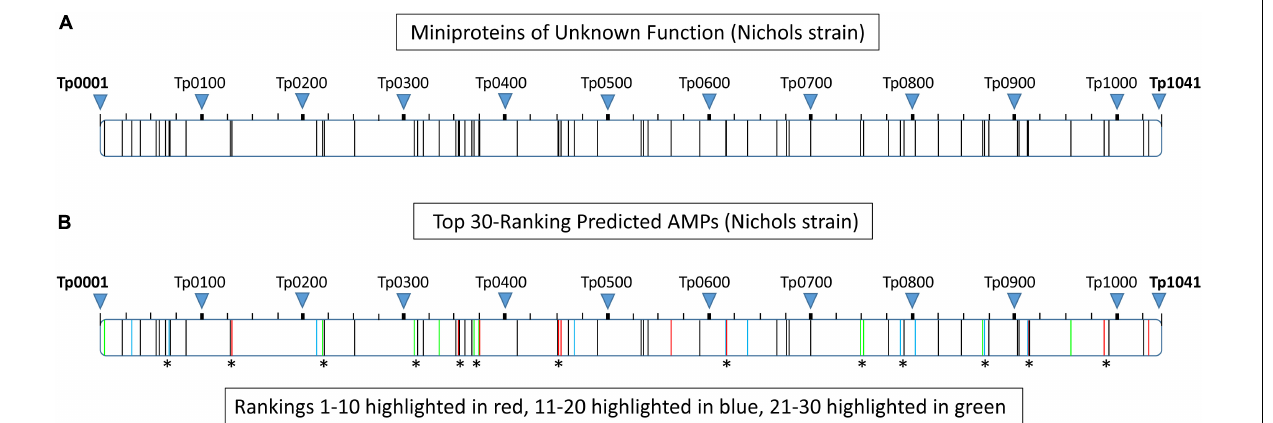
FIGURE 4 | Proteome clustering of T. pallidum (Nichols strain) miniproteins of unknown function. Each of the T. pallidum (Nichols strain) proteins ( ≤ 150 amino acids) of unknown function were arranged from the lowest (Tp0004) to the highest (Tp1032) locus tag number within the proteome (Tp0001–Tp1041) and clusters comprised of at least two miniproteins separated by five or less intervening proteins were identified. (A) Schematic depicting the spatial arrangement of all miniproteins ( ≤ 50 amino acids) of unknown function within the T. pallidum (Nichols strain) proteome. The location of each protein within the proteome is represented by a vertical black line. (B) Schematic showing the spatial arrangement of the 30 top-ranking predicted AMPs within the T. pallidum (Nichols strain) proteome. The location of proteins corresponding to rankings 1–10, 11–20, and 21–30 are shown in red, blue, and green, respectively. Asterisks denote the location of 20 of the top 30-ranking predicted AMPs that are found to be located within 13 miniprotein